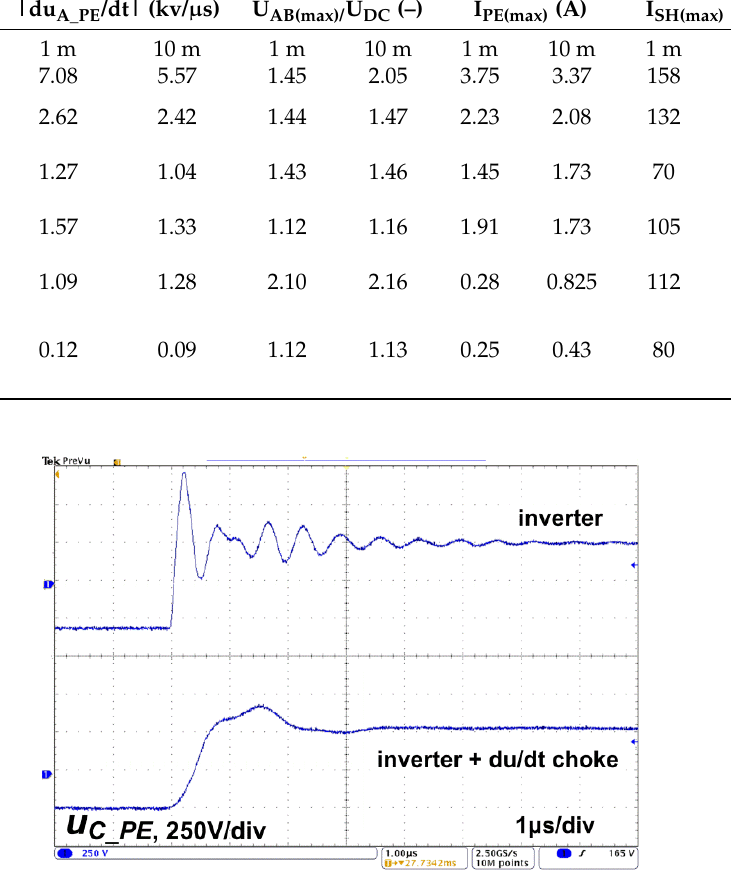
Figure 20. Experimental waveforms of voltage u C_PE recorded in a configuration with a single inverter and in the configuration of an inverter with a 0.31 mH du/dt choke (10 m cable). Besides the reduction in the du/dt gradient, an impact of the considered solutions on the u C_PE voltage spectrum is also perceptible. In comparison with other solutions, the